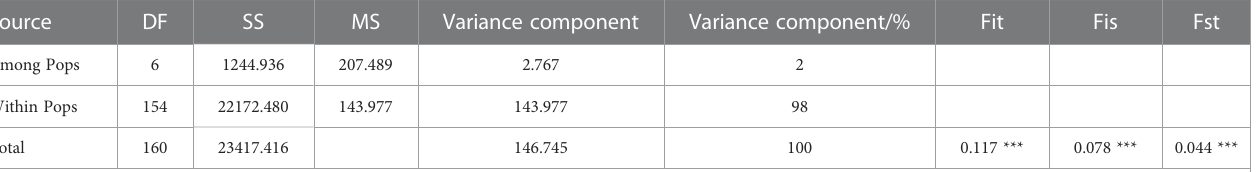
TABLE 4 MANOVA for the population of Korean pine clones.